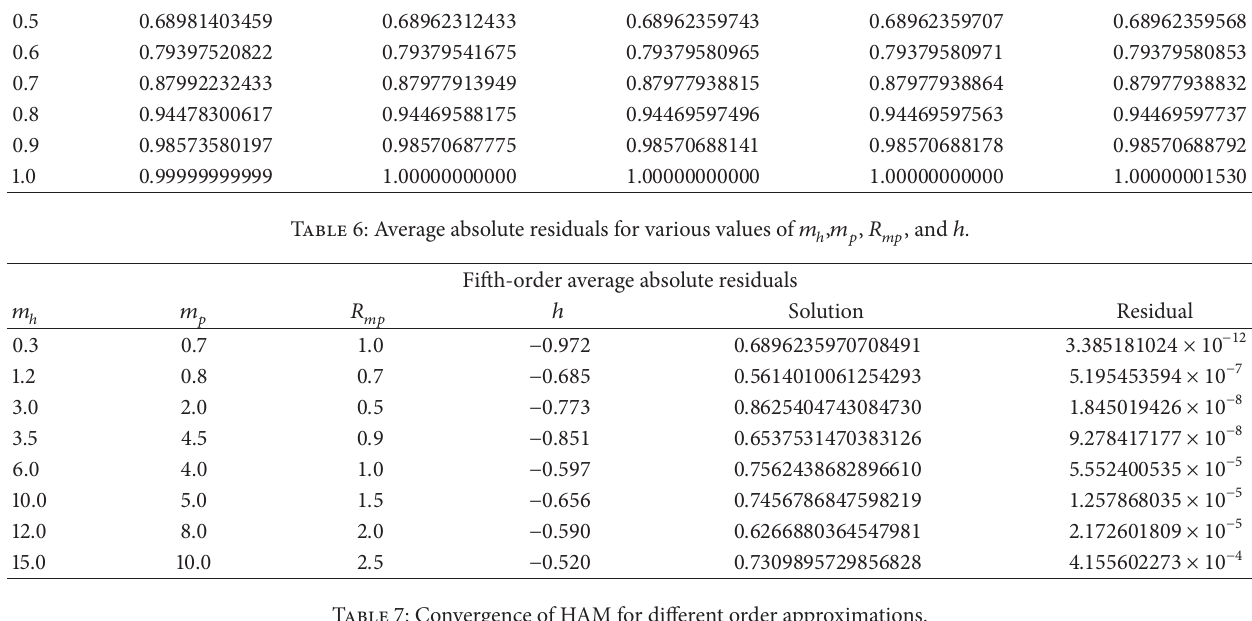
Table 7: Convergence of HAM for different order approximations.